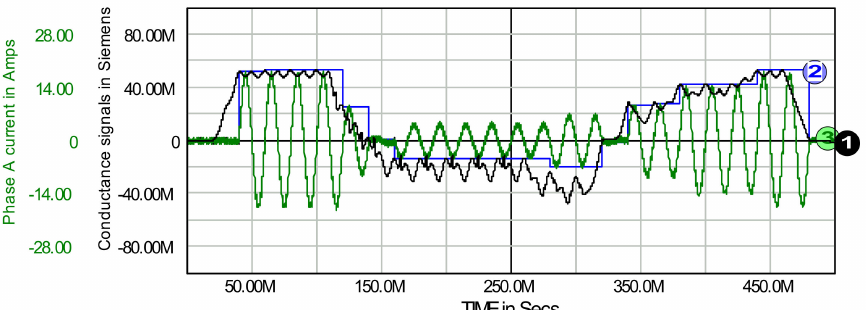
Figure 24. Analog conductance signal: waveform 1 (in black), sampled conductance signal: waveform 2 (in blue) and source phase A current: waveform 3 (in